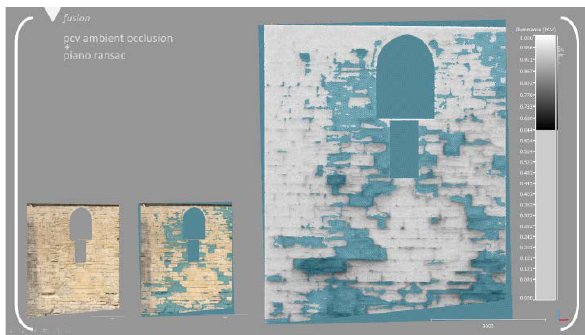
Figure 10. Overlap between RANSAC plane and map of luminance.